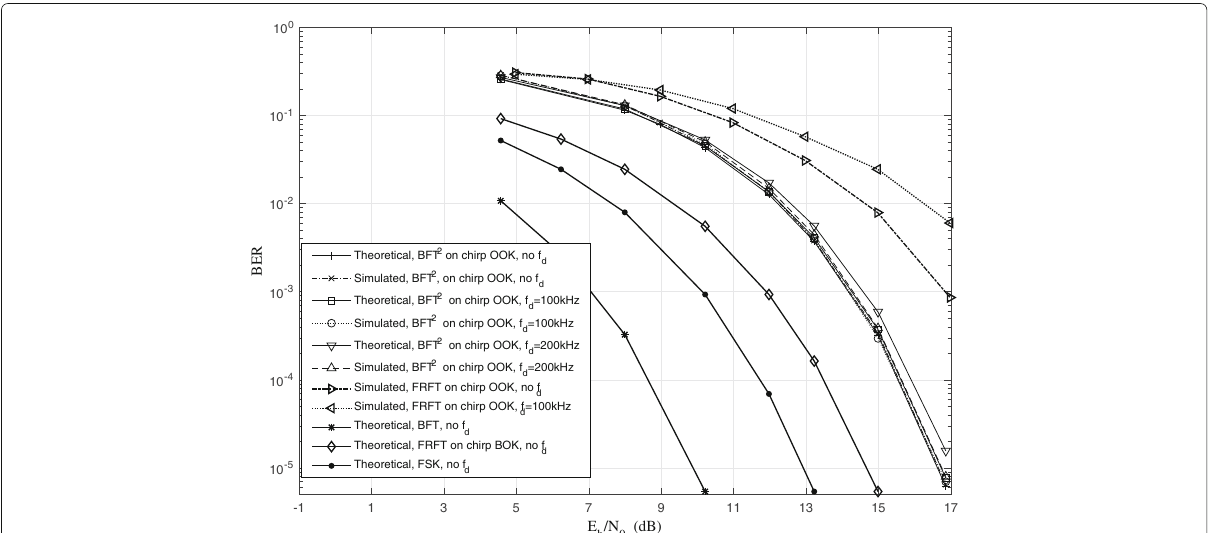
Fig. 7 Performance of D-BFT detection with frequency offset. The figure compares the BER performances among D-BFT detection, FSK in AWGN and Doppler channel